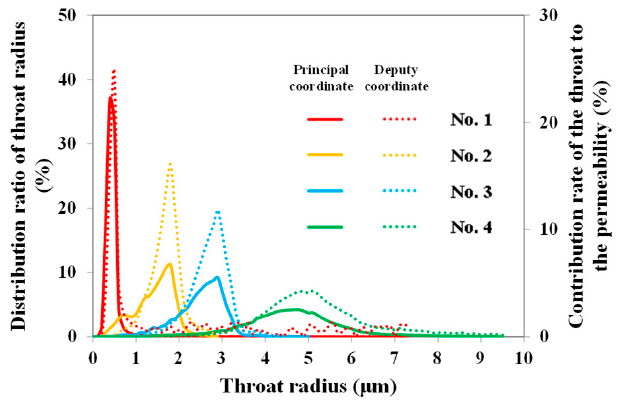
Figure 2. Throat radius distribution of each core.